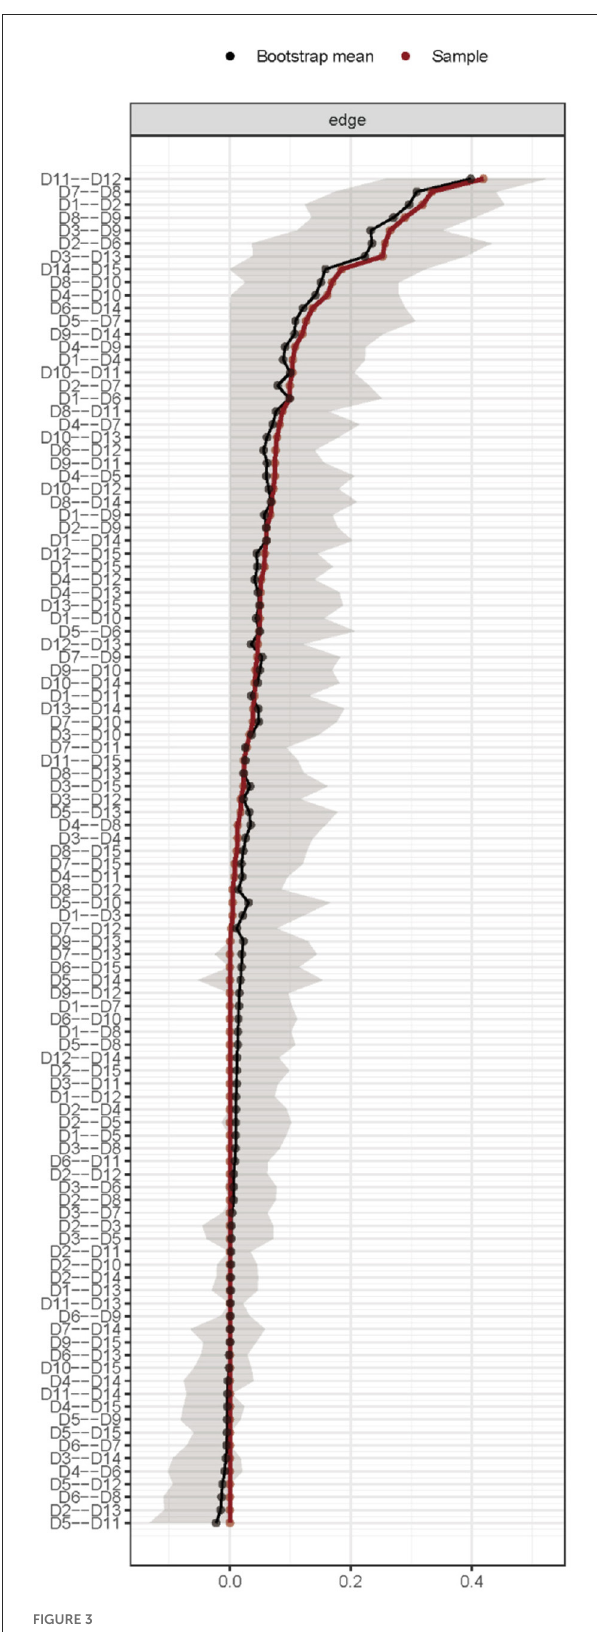
FIGURE3 Edge accuracy plot depicting 95% confidence obtained from 2,500 bootstrap